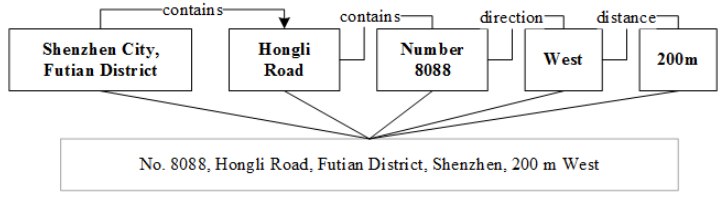
Figure 4. An example of the spatial relationship model.